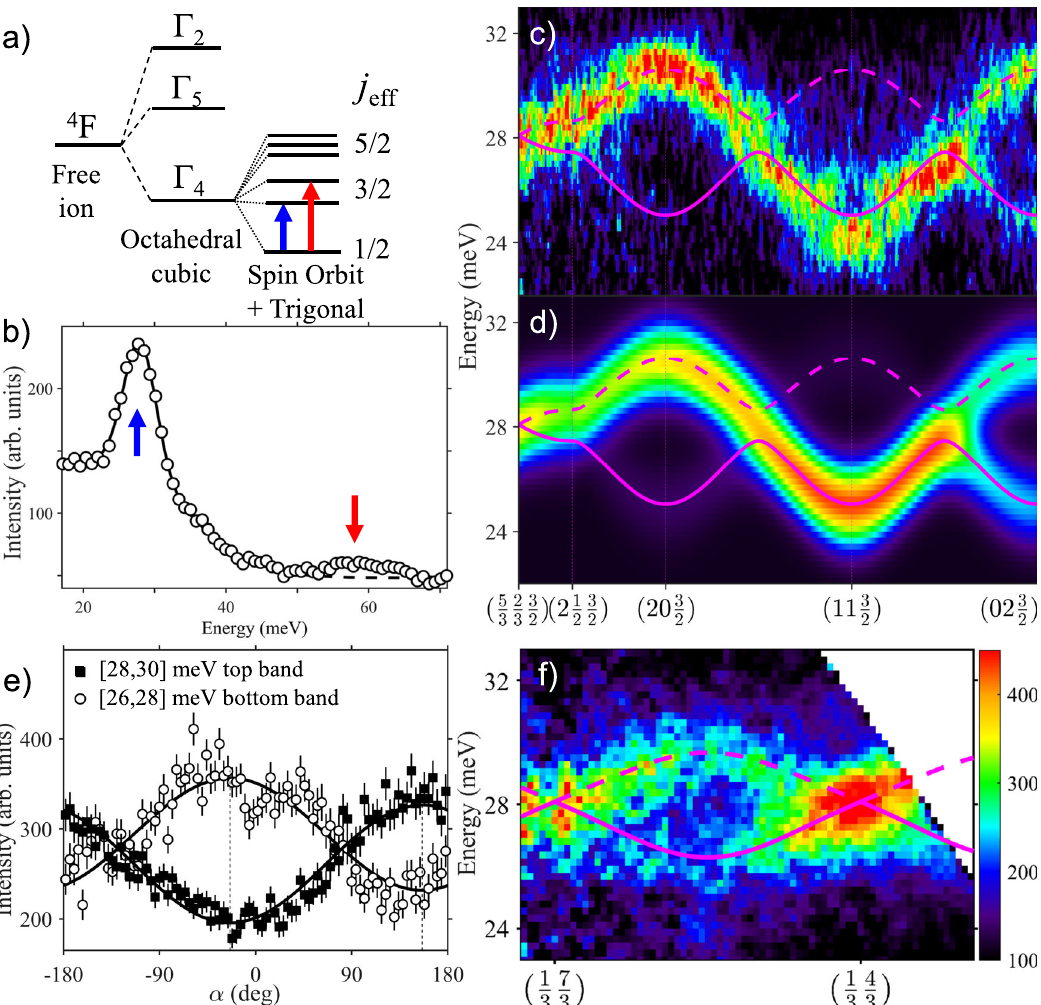
Fig. 4 Spin-orbit excitons: dispersions and Dirac node. a Schematic level splitting for a Co 2 + ion in an octahedral crystal fi eld of trigonal symmetry including spin-orbit coupling. b INS energy scan observing transitions to the fi rst two excited crystal fi eld levels (the blue/red arrows above the peaks show the transitions indicated by matching colour vertical arrows in a , the solid line is a guide to the eye. c INS data probing the dispersions of the fi rst crystal fi eld level along high-symmetry directions, compared in d with a tight-binding model (thick solid/dashed lines through both graphs show best fi t dispersions). e Angular intensity dependence around the nodal point (2/3,5/3) for the top/bottom exciton bands fi tted to an A ¼ 155 ð 3 Þ (cid:4) , calculated 153(1) ∘ , in-plane radial wavevector range [0.075, 0.3] Å − 1 ). The black squares/white circles denote the inelastic (solid lines, ~ α 0 neutron scattering intensity for the top/bottom exciton bands, respectively, with error bars representing one standard deviation. Note the analogous behaviour to the intensity dependence in azimuthal scans for Dirac magnons in Fig. 2c. f Exciton bands crossing at the two labelled nodal Dirac points, analogous to the magnon bands crossing in Fig. 2f). In e , f intensities are averaged for L = [0, 3.5], in c for a transverse wavevector range ±0.1 Å − 1 , and in f for a transverse in-plane wavevector range ±0.025 Å − 1 . Data were collected at 8 K with E i = 83 meV in b and 45 meV in c , e , f . The colour bar in f also applies to c and d , and indicate scattering intensity in arbitrary units on a linear